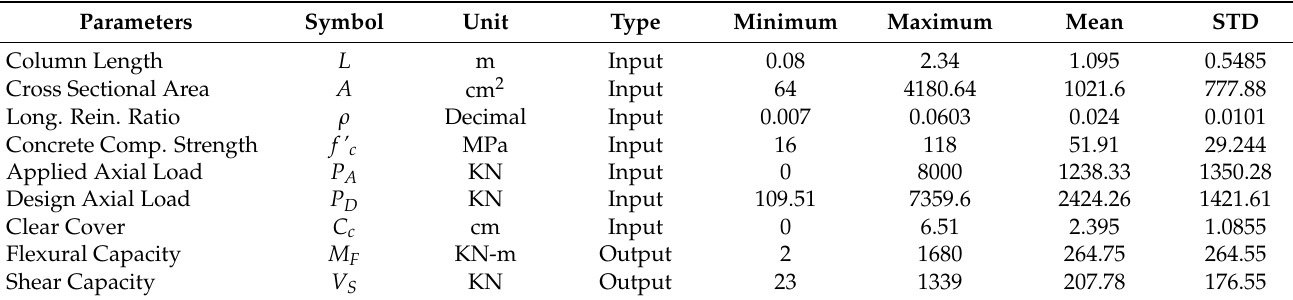
Table 3. Statistical Characteristics of Model